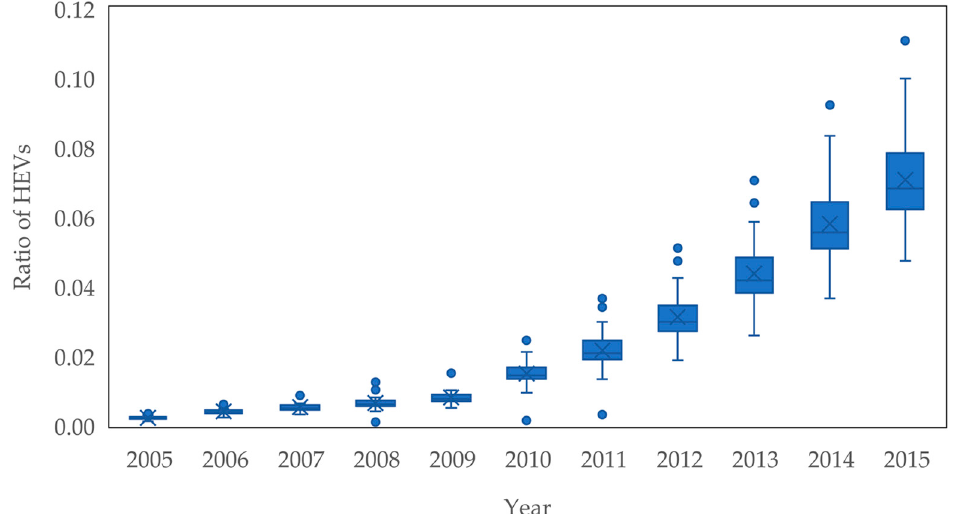
Figure 1. Trend of the ownership ratio of HEVs at the prefecture level. Each box shows the 75th percentile, median, and 25th percentile of the samples (from the top). The whiskers show the maximum and minimum values (excluding the outliers). The cross marks show the mean values, whereas the circles show the outlier points.